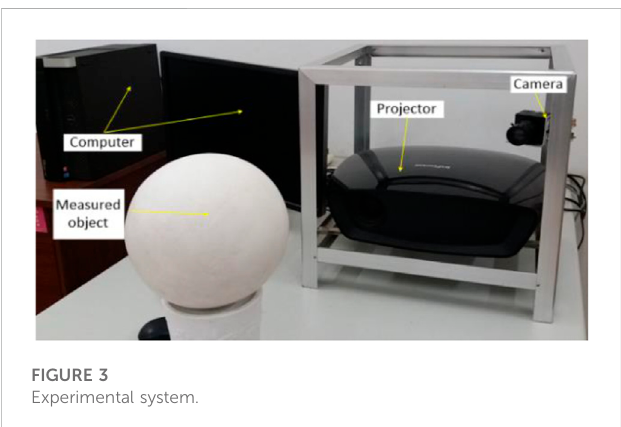
FIGURE 3 Experimental